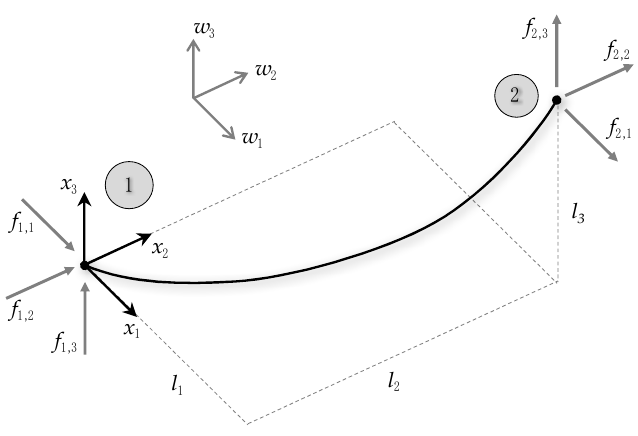
Figure 2. 3D modelling of a single wire.